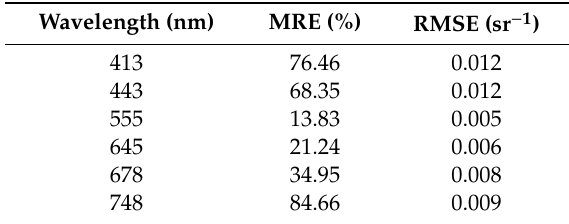
Table 5. Error statistics of R rs derived from the original MOD09.